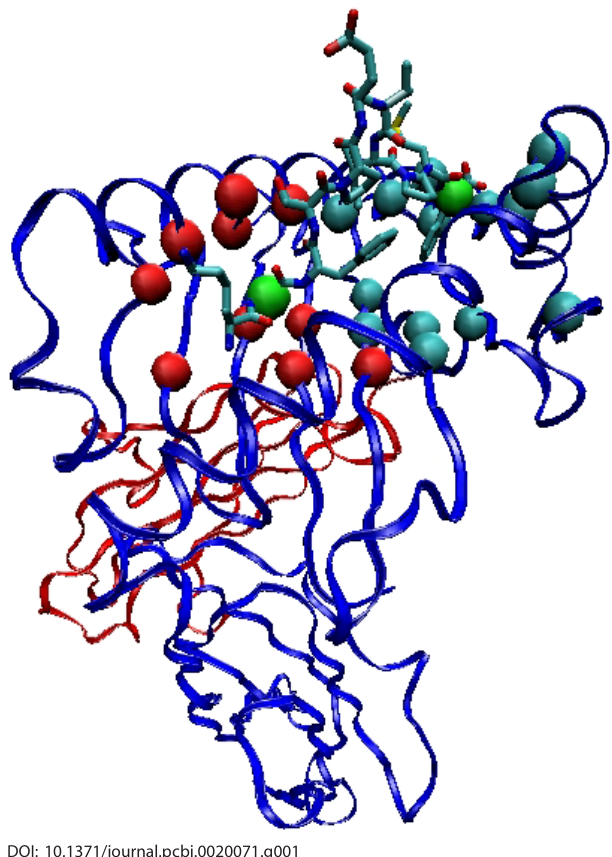
Figure 1. Interaction of an Epitope with an MHC Class I Protein Ribbon representation of the 1.65 A˚ resolution X-ray crystal structure of the MHC I allele B*5703 in complex with the KAF-11 peptide (KAFSPEVIPMF) derived from the HIV-1 p24 capsid protein. The blue ribbon indicates the alpha chain, the red chain is beta-2 microglobulin, and the molecule in the binding cleft is the antigenic peptide. The red and blue-green spheres mark the alpha carbons of the canonical peptide-binding B- and F-pocket residues, respectively. The green spheres represent the alpha carbons of the peptide anchor residues at P2 and